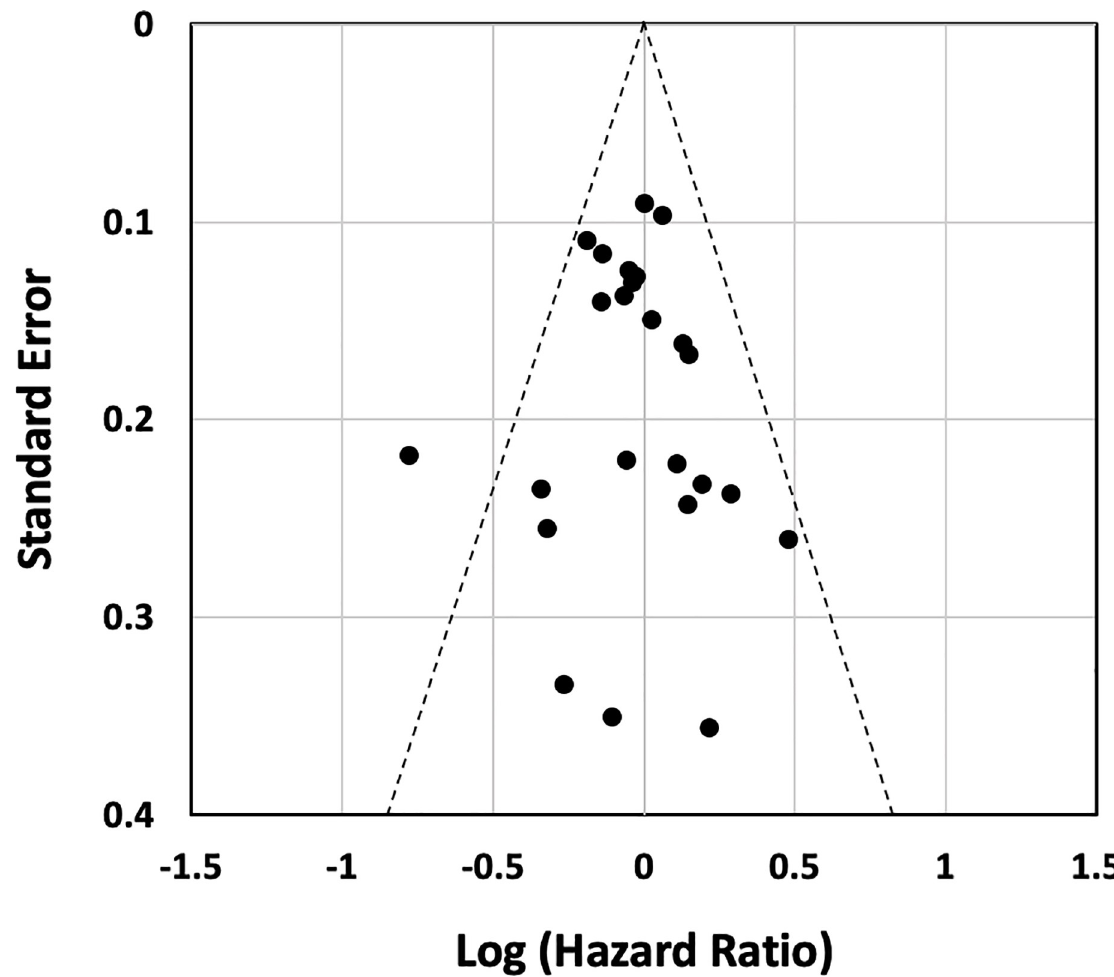
Fig 3. Funnel plot of the including studies evaluating the presence of publication